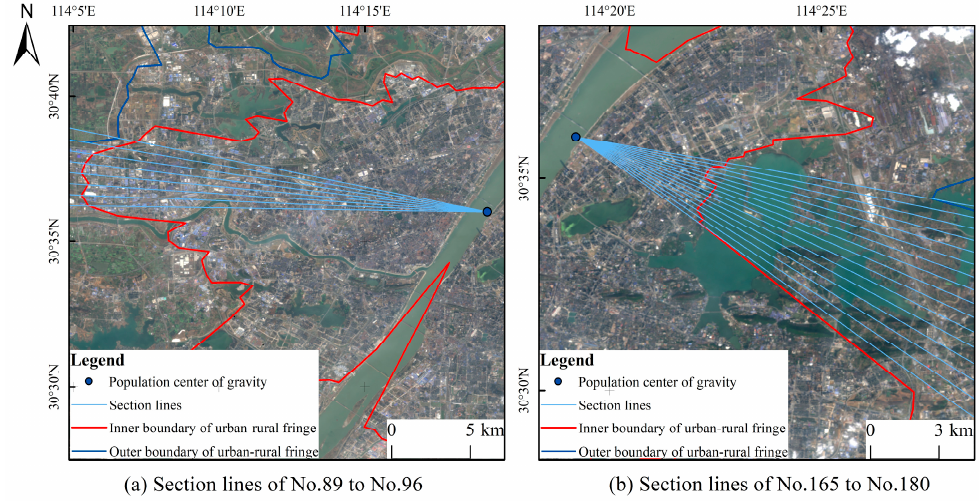
Figure 11. Schematic diagram of remote sensing image at section lines.